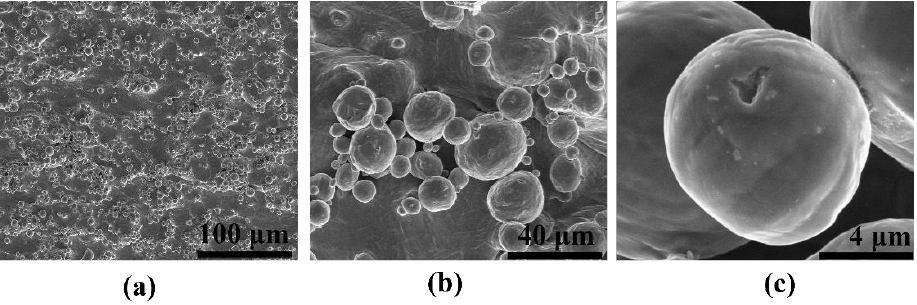
Figure 2. SEM images of the surface topography of the Ti 3D after PBF-LB process. Magnification of images is: ( a ) 100×, ( b ) 1000× and ( c ) 10,000×.